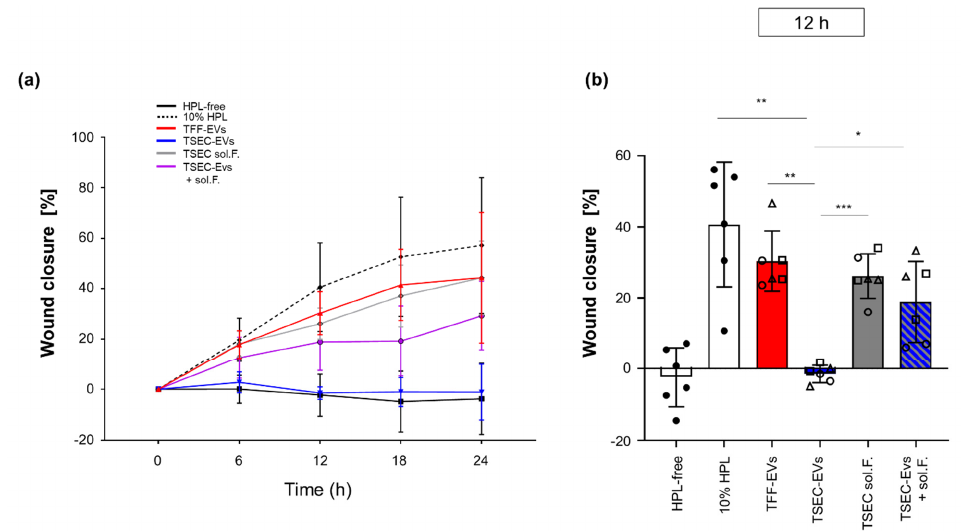
Figure A3. Wound healing scratch assay. Human skin fibroblasts from two healthy donors were seeded in scratch assay chambers before treatment with different HPL-derived EV and soluble fraction preparations. ( a ) Time course of scratch wound closure in the absence (HPL-free medium control) or presence of different EV-containing and EV-free fractions as indicated. ( b ) Detailed comparison of scratch wound closure after 12 h. Three independent HPL-derived biological replicate EV and soluble fraction preparations (shown as open triangles, circles and squares as indicated) were tested for their impact on scratch wound closure of two independent skin fibroblast preparations. One-way ANOVA repeated measures (* p < 0.05, ** p < 0.01, *** p < 0.001).